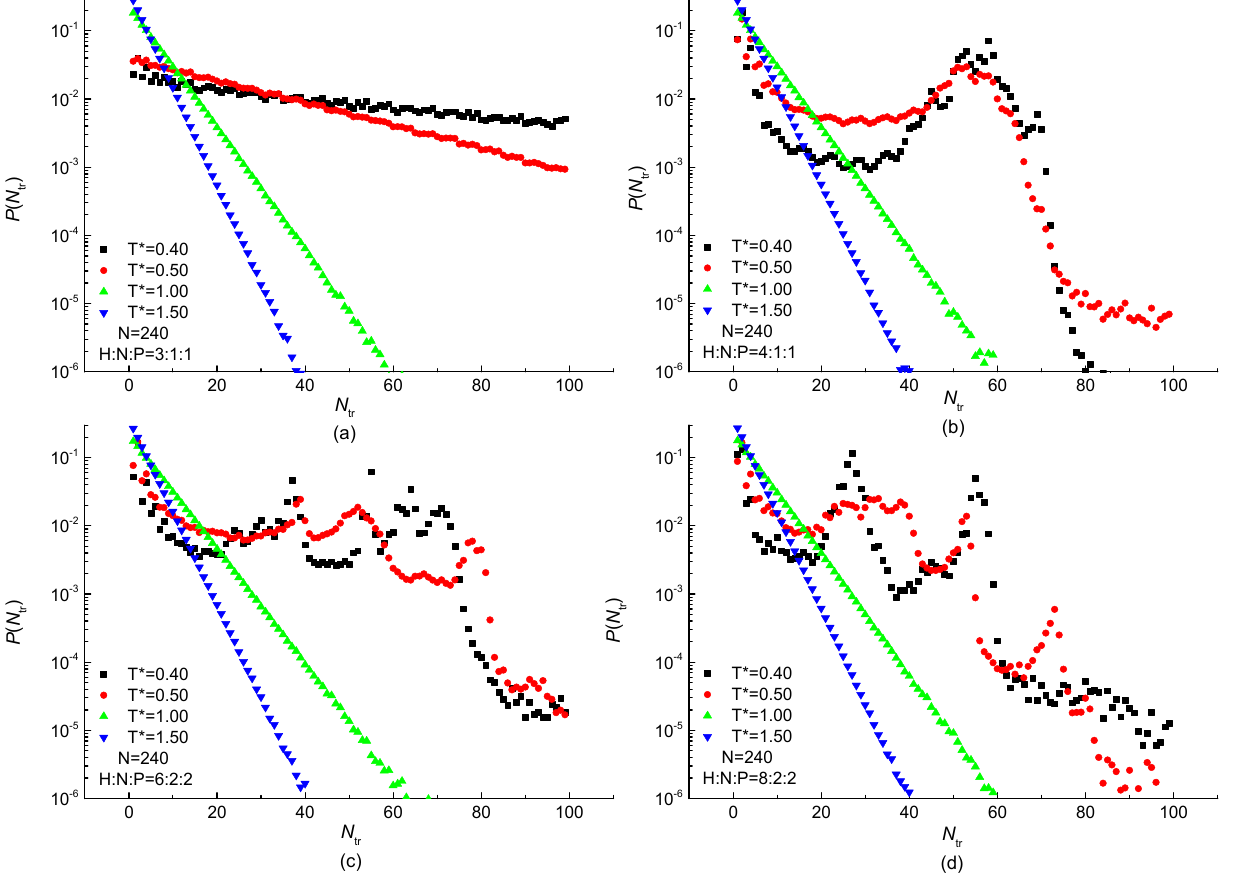
Figure 10. Distribution of stem length under different temperatures in linear-lg plot of ( a ) H3N1P1, ( b ) H4N1P1; ( c ) H6N2P2 and ( d ) H8N2P2 proteins with chain length of N = 240 residues.